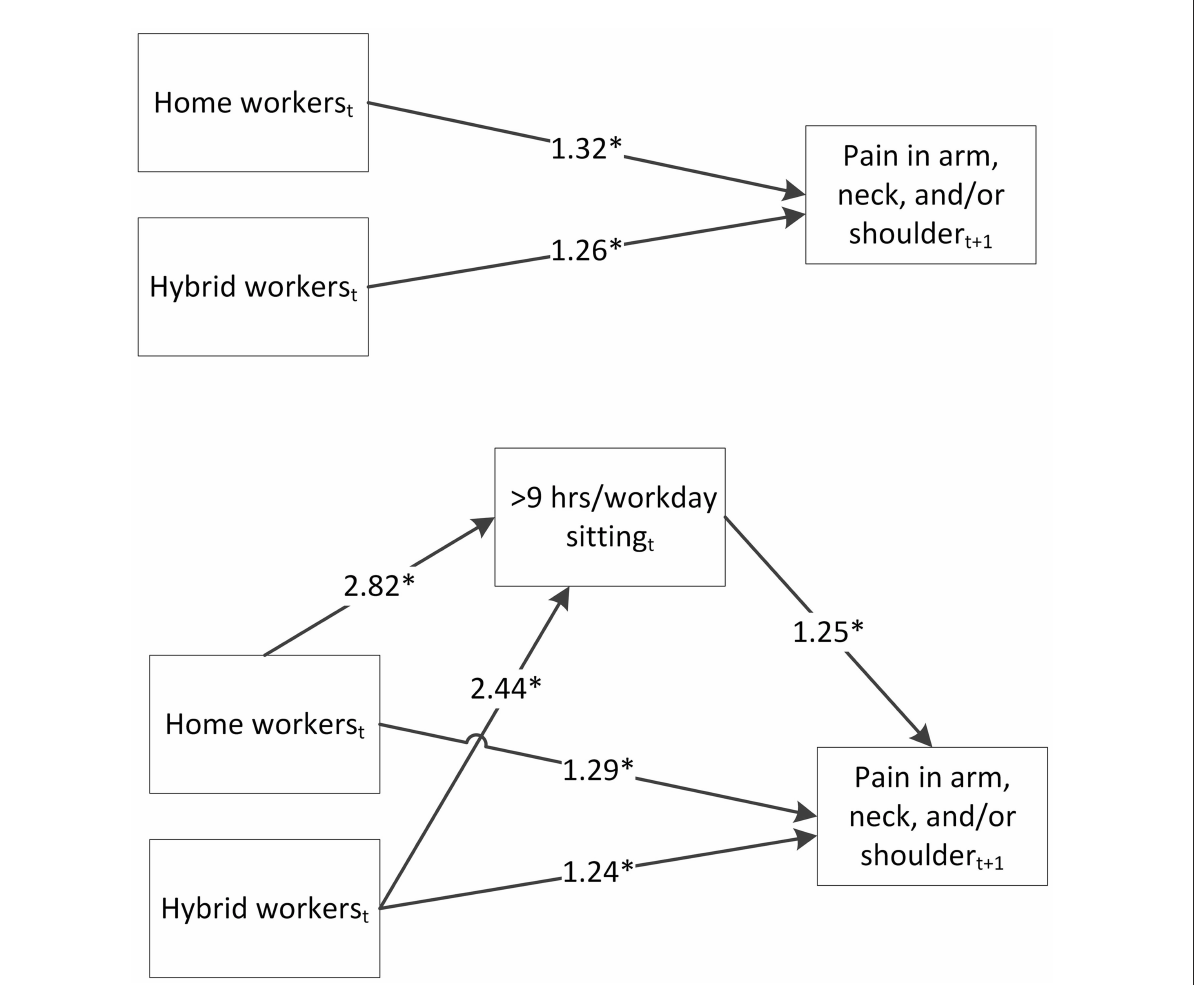
FIGURE2 Longitudinal mediation model showing the odds ratios of the total effect of work situation measured in round t on pain in the arm, neck, and/or shoulder measured in round t + 1, the indirect effect of sedentary behavior measured in round t , and the direct effect of work situation on pain in the arm, neck, and/or shoulder ( n = 14,333). Odds ratios are adjusted for age, sex, education level, country of birth, household composition, occupation, occupational class, employment contract, general health, and sedentary behavior before the pandemic. * p <